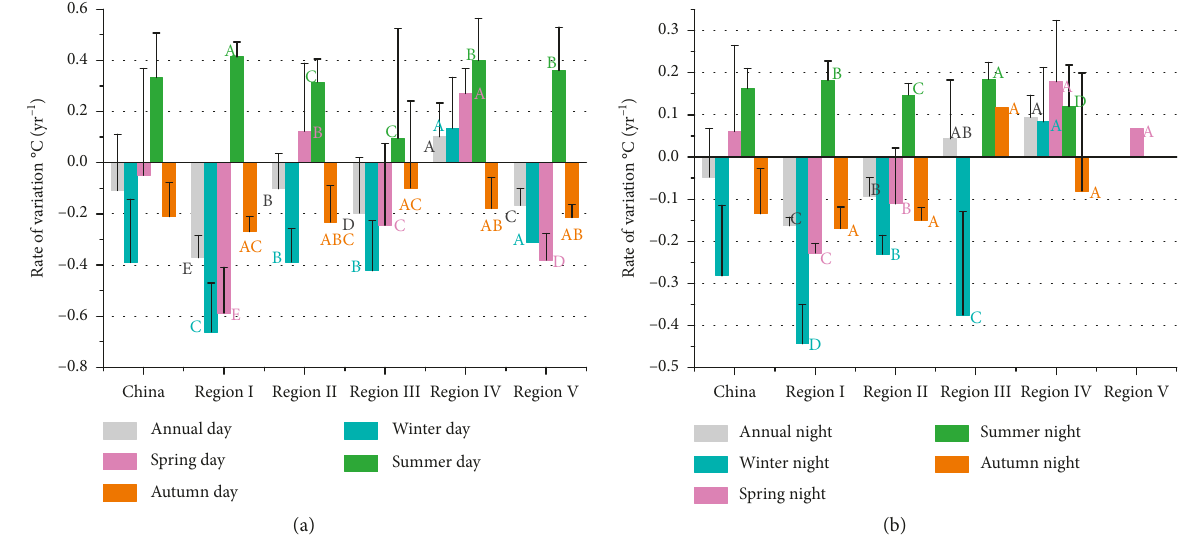
Figure 3: Statistics of the variation rates of mean LSTs in rural regions that significantly changed in the whole year and four seasons during the daytime and night-time from 2003 to 2013 in the five environmental regions, China (A–E represent the mean comparison results among regions, using nonparametric tests of k independent samples; significant differences only existed in rural LSTs among the five environmental regions when the label letters were the